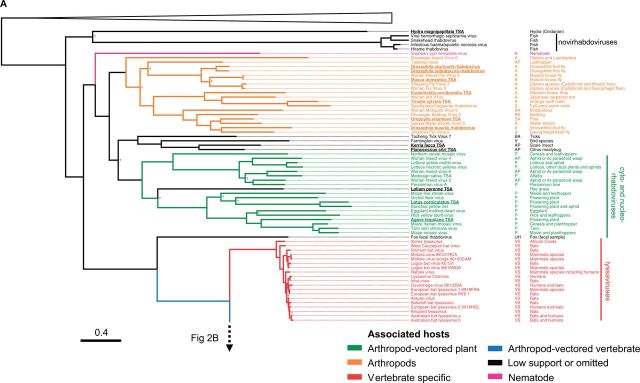
ML phylogeny of the Rhabdoviridae.
(A) shows the basal fish-infecting novirhabdoviruses, an unassigned group of arthropod associated viruses, the plant infecting cyto- and nucleo-rhabdoviruses, as well as the vertebrate specific lyssaviruses. (B) shows the dimarhabdovirus supergroup, which is predominantly composed of arthropod-vectored vertebrate viruses, along with the arthropod-specific sigma virus clade. Branches are colored based on the Bayesian host association reconstruction analysis. Black represents taxa omitted from host-state reconstruction or associations with <0.95 support. The tree was inferred from L gene sequences using the Gblocks alignment. The columns of text are the virus name, the host category used for reconstructions, and known hosts (from left to right). Codes for the host categories are: VS, vertebrate-specific; VV, arthropod-vectored vertebrate; A, arthropod specific; BS, biting-arthropod (ambiguous state); V, vertebrate (ambiguous state); AP, plant-sap-feeding-arthropod (ambiguous state); UH, uncertain-host (ambiguous across all states); and N, nematode. Names in bold and underlined are viruses discovered in this study. The tree is rooted with the Chuvirus clade (root collapsed) as identified as an outgroup in (Li et al. 2015) but we note this gives the same result as midpoint and the molecular clock rooting. Nodes labelled with question marks (?) represent nodes with aLRT (approximate likelihood ratio test) statistical support values less than 0.75. Scale bar shows number of amino-acid substitutions per site. Bayesian MCC tree used to infer ancestral traits is shown in Supplementary Figure S4.